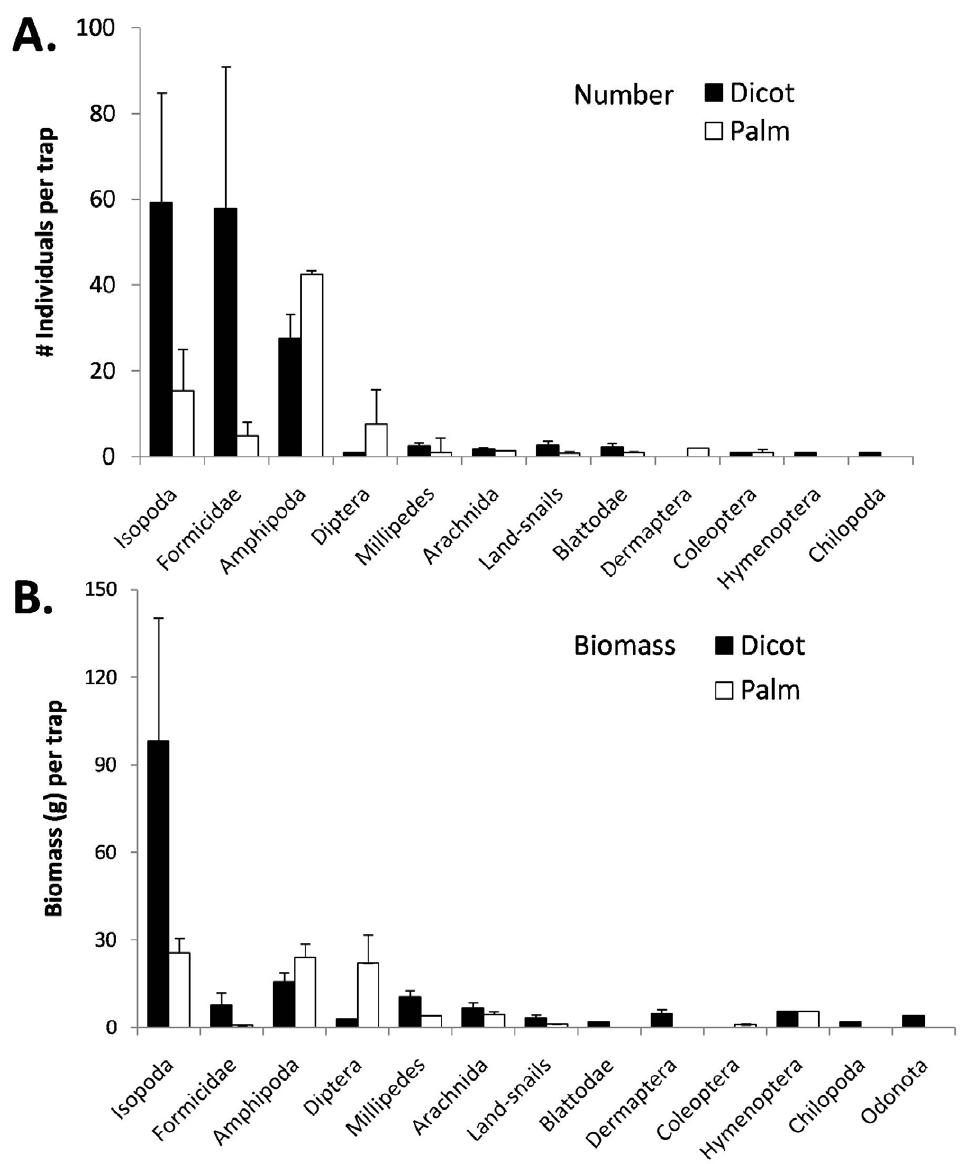
Figure 2. Stomach contents of two species of gecko ( Lepidodactyluslugubris and Lepidodactylus sp. nov.) across forest types. Diet diversity, as estimated by Shannon diversity index, is indicated by forest type. Indices with different letters indicate significant differences based on comparisons with Hutchenson’s test; indices that share the same letters are not significantly different from each other.